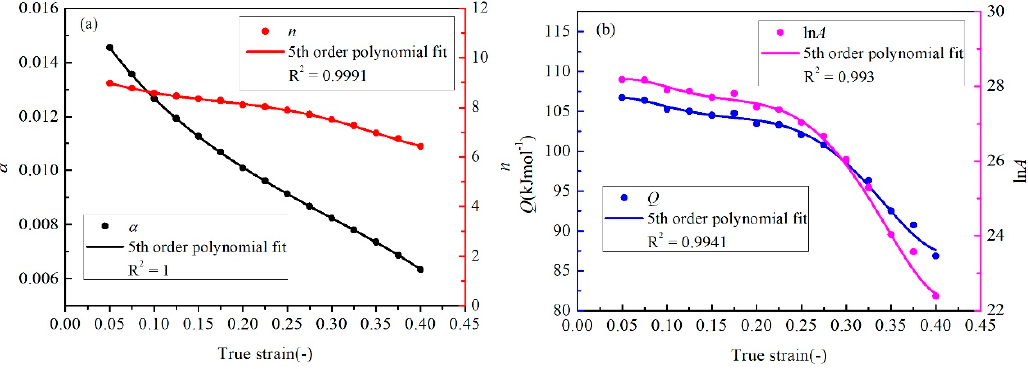
Figure 16. The variation of ( a ) α and n , ( b ) Q and ln A at 15 true strains fit with the fifth order polynomial. Table 2. The value of each coefficient in the expression of material constants.